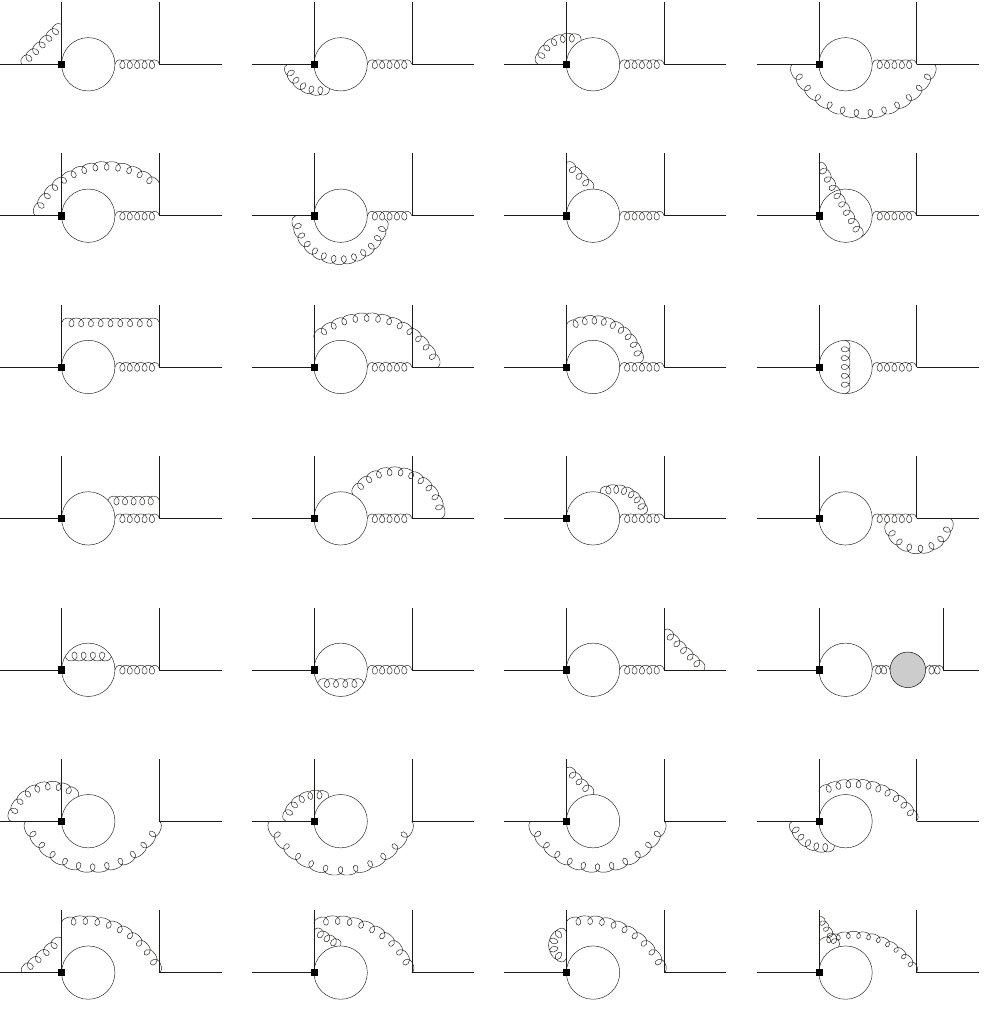
Figure 4 . Two-loop penguin diagrams